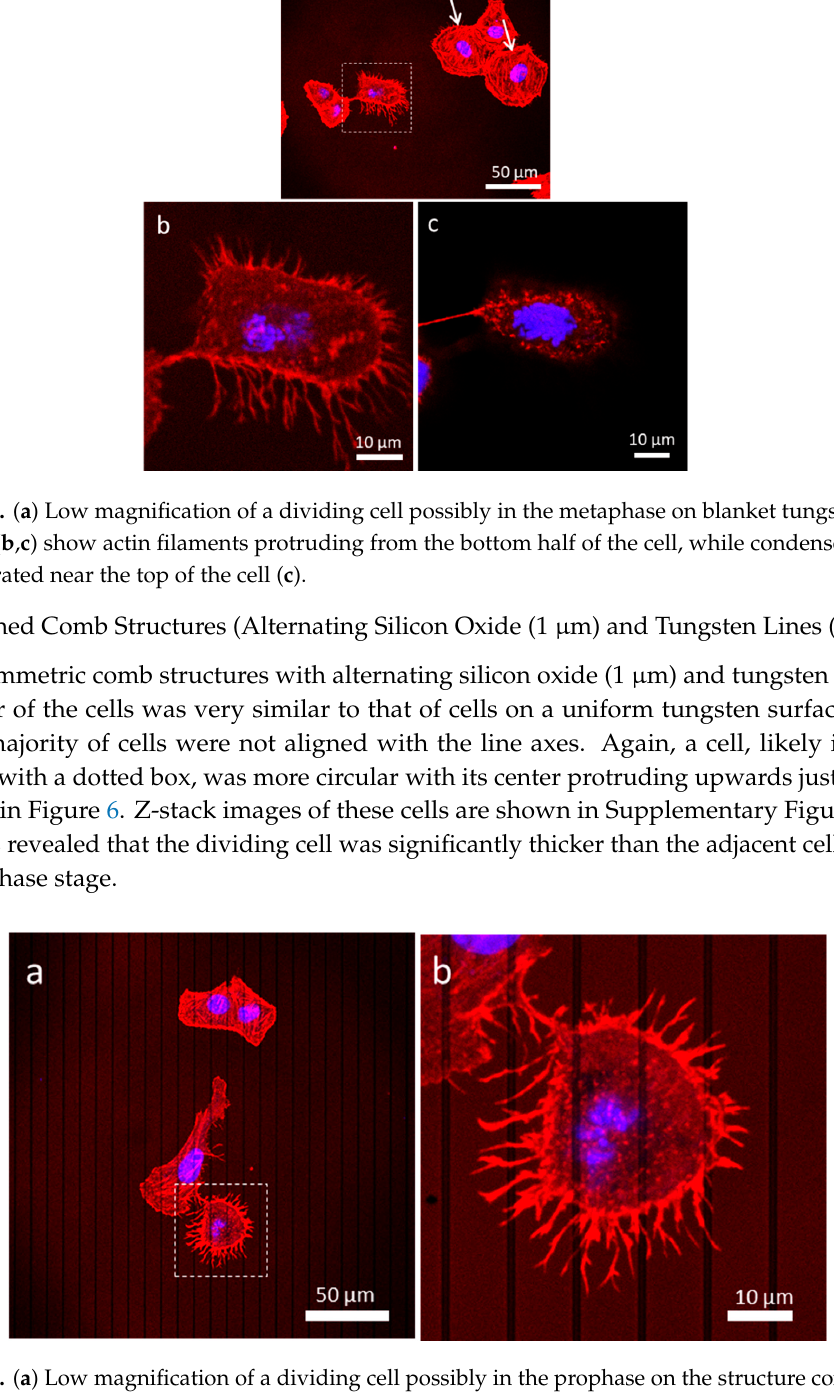
Figure 8. ( a ) Low magnification of a dividing cell possibly in the metaphase on the structure containing alternating tungsten and silicon oxide lines of an equal width of 5 µm. ( b ) High magnification image shows actin filaments protruding from the bottom half of the cell. 3.4.4. Patterned Comb Structures (Alternating Silicon Oxide (9 µm) and Tungsten Lines (1 µm)) Non-dividing cells on this line structure were well aligned, as shown in Figure 9. Three fully spread cells in interphase aligned to the line axes. The cell highlighted with an arrow in the micrograph was undergoing mitosis (possibly in telophase). Figure 9b shows a high magnification micrograph of this dividing cell recorded at a z-plane near the center portion of the cell. The confocal image confirmed that the two emerging daughter cells were near spherical in shape and were not aligned to the line axes. 3.4.5. Isolated Tungsten Lines (1 µm Tungsten Line Inlaid in a SiO 2 Continuous Phase) One Vero cell appeared to be in the interphase stage of mitosis labelled with an arrow (Figure 10a). This cell was elongated along the tungsten line. Two adjacent cells likely in telophase were on the same isolated line. The cells were compact with a dumbbell shaped geometry. High magnification z-stack images of these dividing cells are shown in Figure 10b,k. The cell at the top appeared to be at the end of the cytokinesis, the final stage of the cell division process, in which the chromosomes appeared decompressed to expanded chromatin. The cell at the bottom appeared to be in telophase, the final stage of mitosis just prior to cytokinesis, showing the condensed chromosomes being pulled